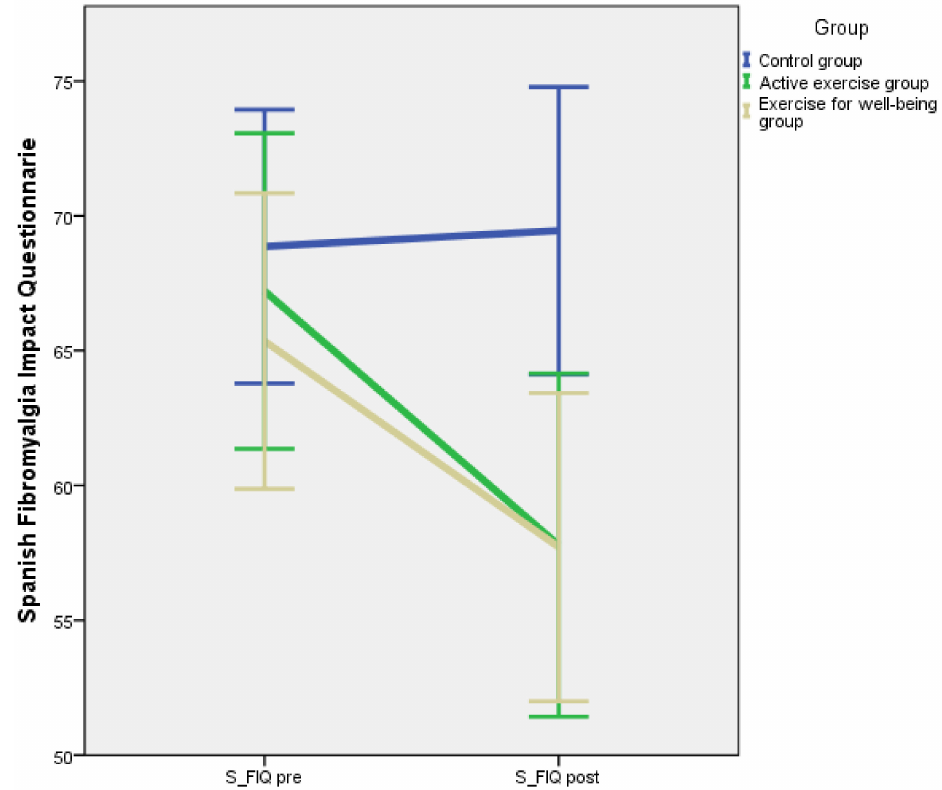
Figure 4. Changes in the Spanish Fibromyalgia Impact